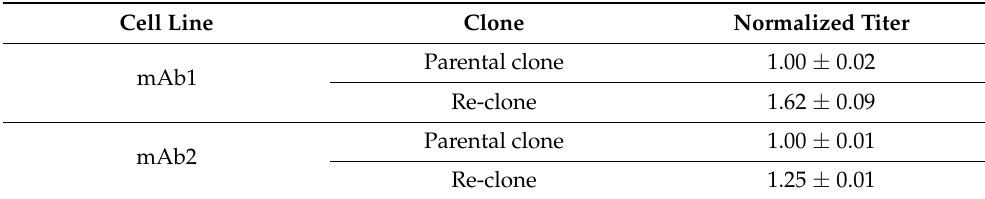
Table 2. Normalized day 14 titer comparison between the parental clone and re-clone in 50-mL TubeSpin bioreactors for mAb1 and mAb2 using the same media and fed-batch production conditions. The values are reported as average ± difference/2 ( n =